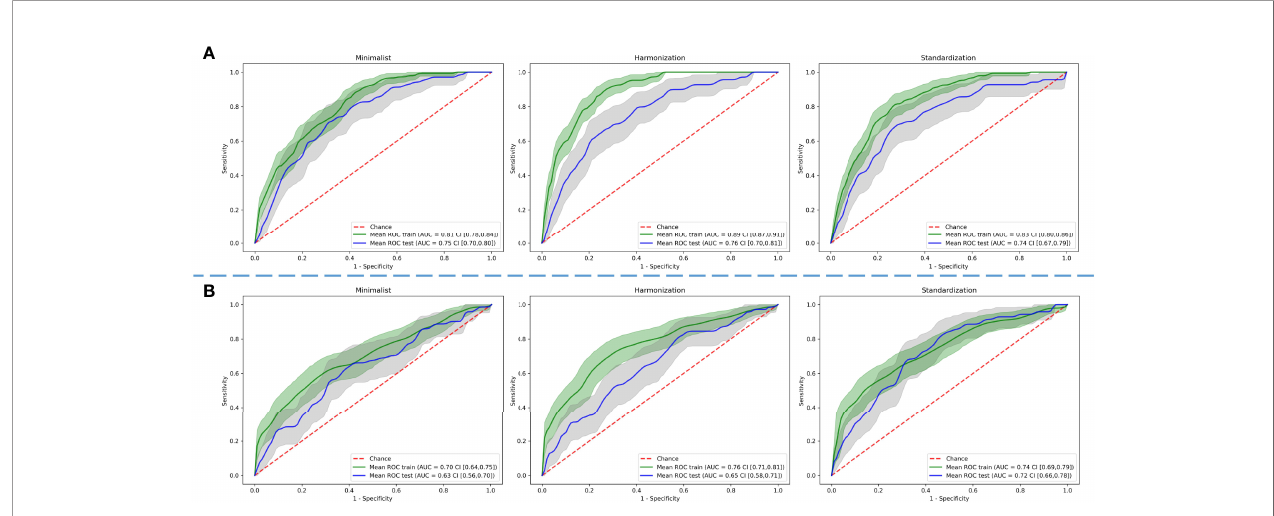
FIGURE 5 | Comparison of predictive performance through receiver operating characteristic curves for (A) radiomics-based machine learning and (B) deep learning models using three different pre-processed image datasets. The shaded areas represent the 95% con fi dence intervals of the corresponding receiver operating characteristic